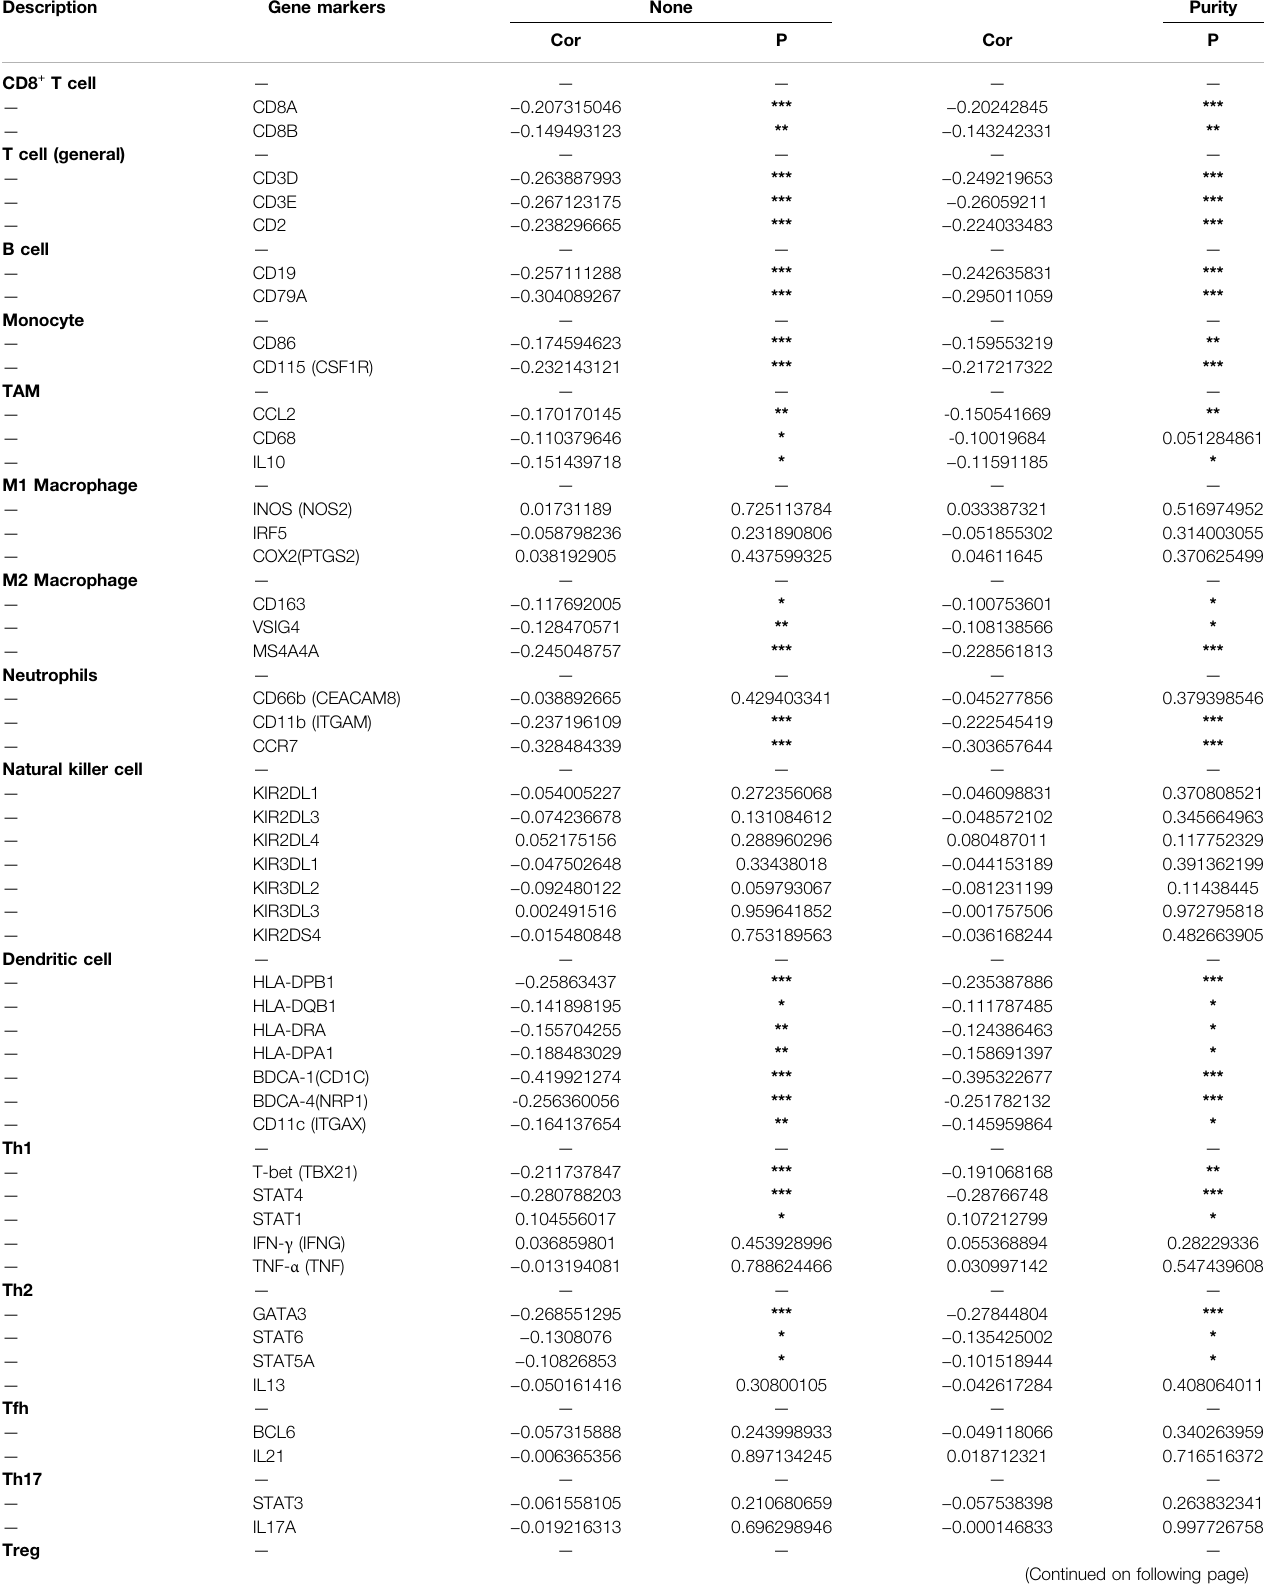
TABLE 3 | Correlation analysis between EFNA3 and relate genes and markers of immune cells in TIMER.